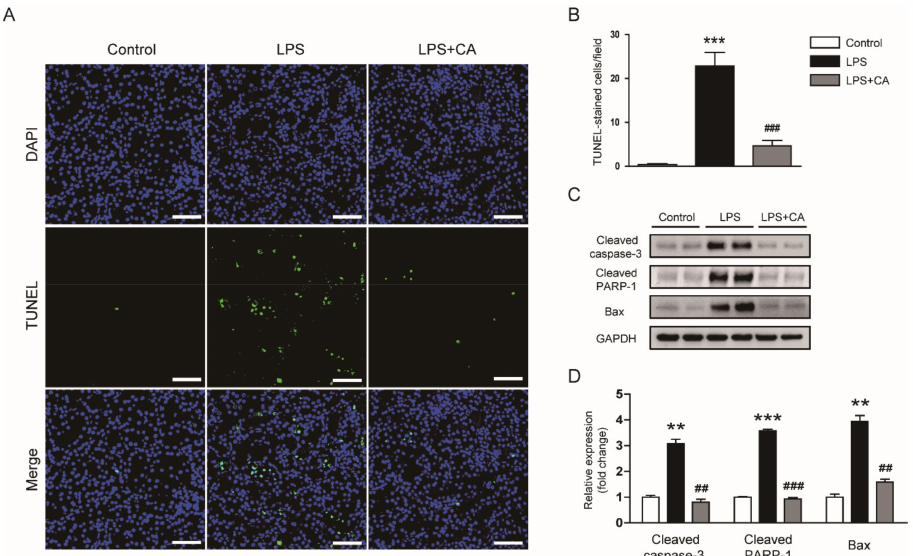
Figure 8. Effect of carnosic acid on apoptosis and caspase-3 activation. ( A ) TUNEL staining. Scale bar: 100 µ m. ( B ) Number of TUNEL-stained cells per field. ( C ) Western blotting of cleaved caspase-3, cleaved PARP-1, and Bax. ( D ) Quantification of Western blot data for cleaved caspase-3, cleaved PARP-1, and Bax. ** p < 0.01 and *** p < 0.001 versus control. ## p < 0.01 and ### p < 0.001 versus